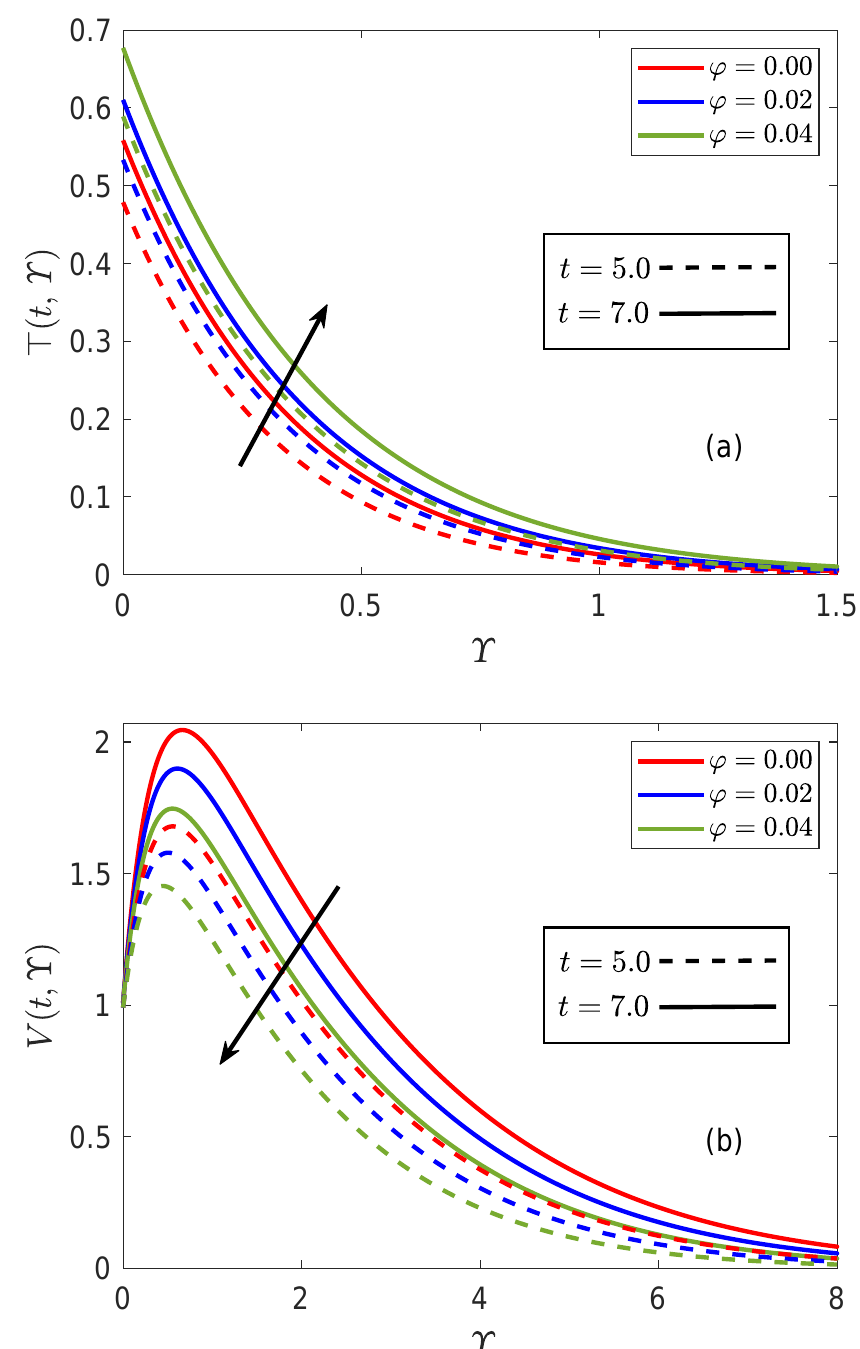
Figure 10. ( a ) Thermal patterns corresponding to variations of ϕ for larger time inputs. ( b ) Flow patterns corresponding to variations of ϕ for larger time